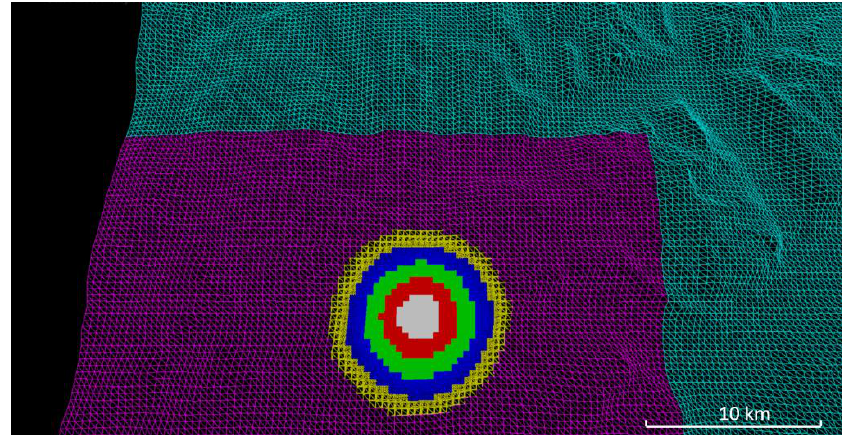
Figure 5. Overall level of detail (LOD) system, including automatic LOD generation by UE4 for all loaded tiles (white, red, green, yellow, and pink) and manual LOD generation for all tiles that are not streamed (cyan).